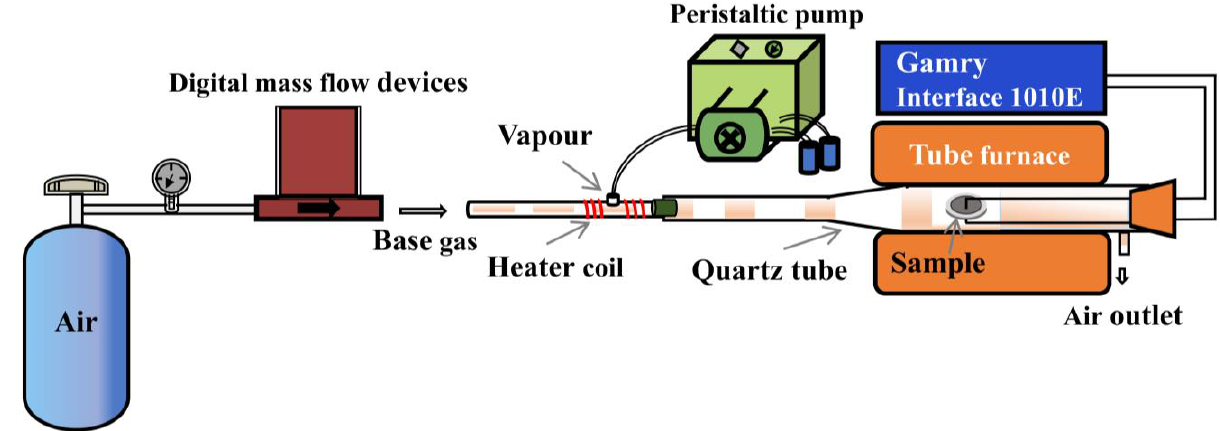
Figure 2. Conductivity testing system.